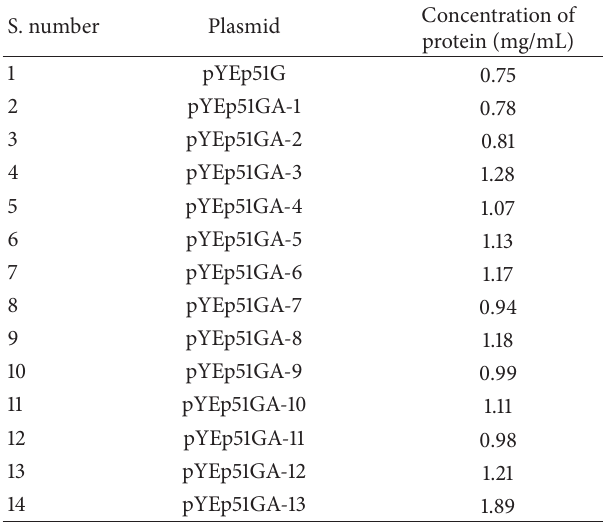
Table 6: GUK1 activities in yeast strains (Sp activity 𝜇 mol/min per mg of